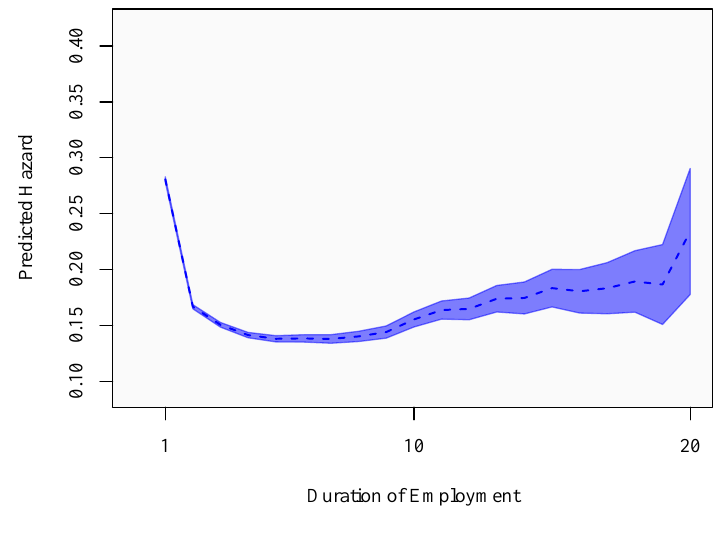
Figure 3. The effect of duration on the sickness absence hazard.